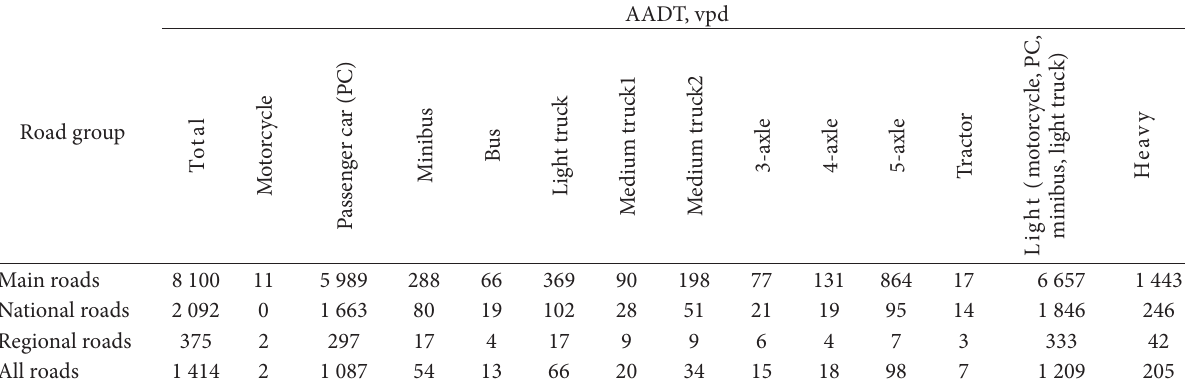
Table 1. Th e AADT of all the classes of vehicles in the diff erent group of roads (Accumulation and renewal of traffi c data of the roads of national signifi cance, 2008)